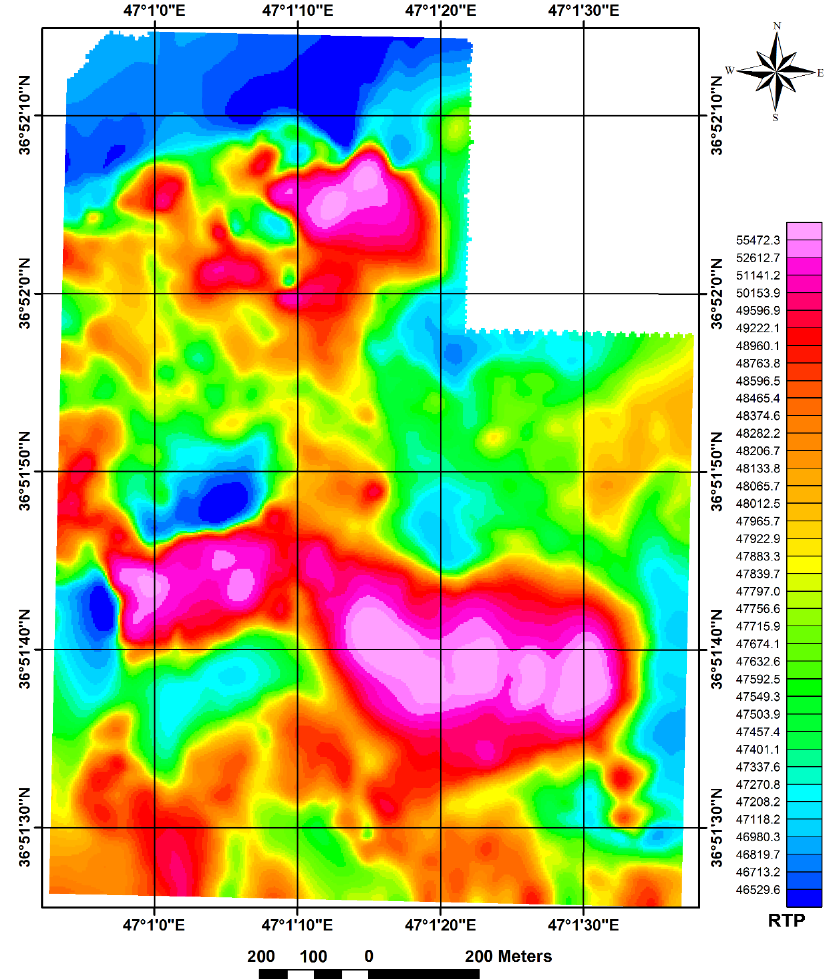
Figure 3. RTP map of Qoja-Kandi based on the reduction-to-the-pole technique.